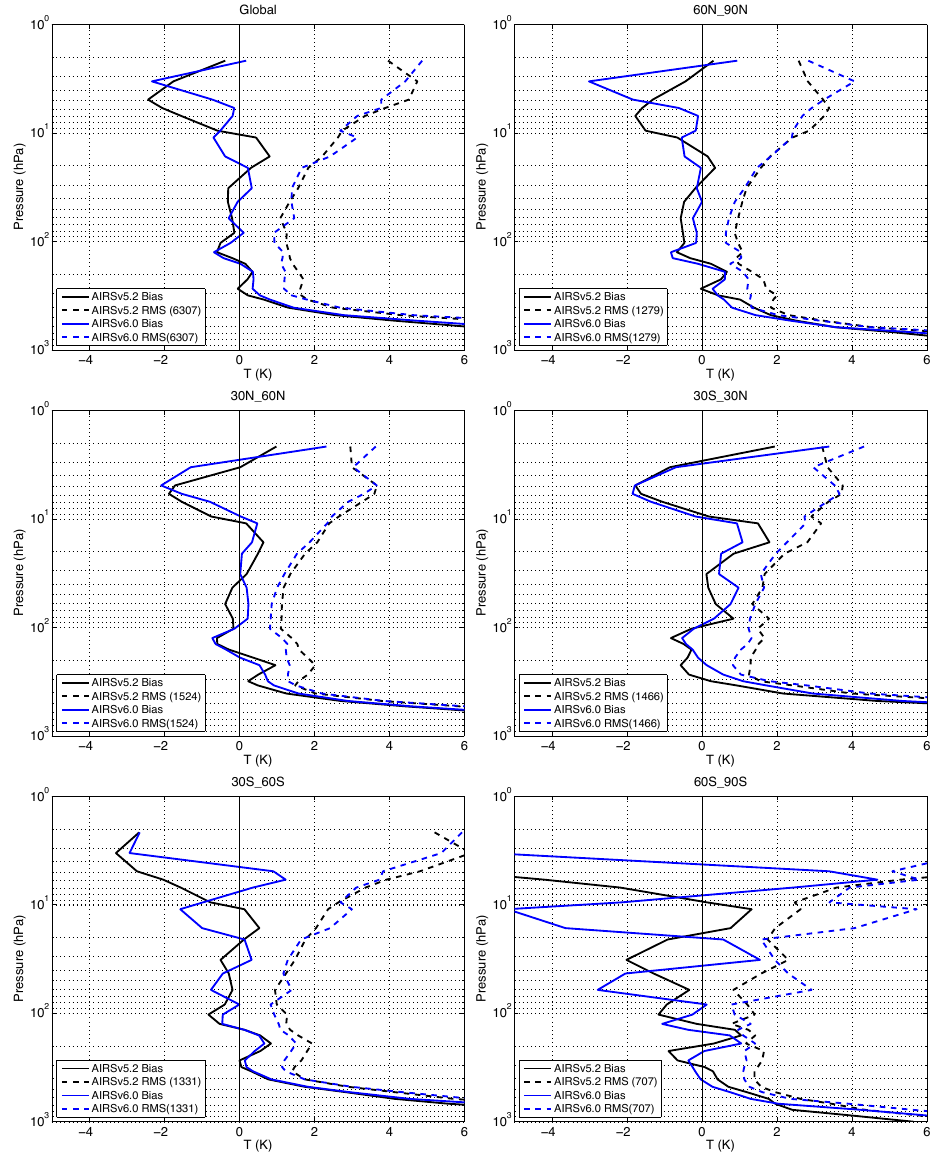
Figure 2. May 2012 NASA AIRS v5.2 minus COSMIC (black) and NASA AIRS v6.0 minus COSMIC (blue) bias (solid line) and rms (dashed line) for global and selected latitude zones. The apparent large positive biases in the middle and lower troposphere are due to the comparison with the COSMIC dry temperatures, which are significantly lower than actual temperatures when significant amounts of water vapor are